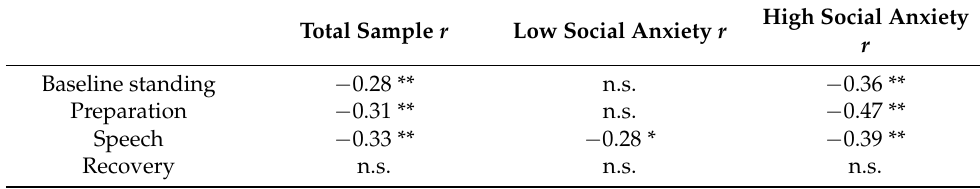
Table 1. Partial correlations ( r , corrected for baseline values) of the log rMSSD and cortisol AUC